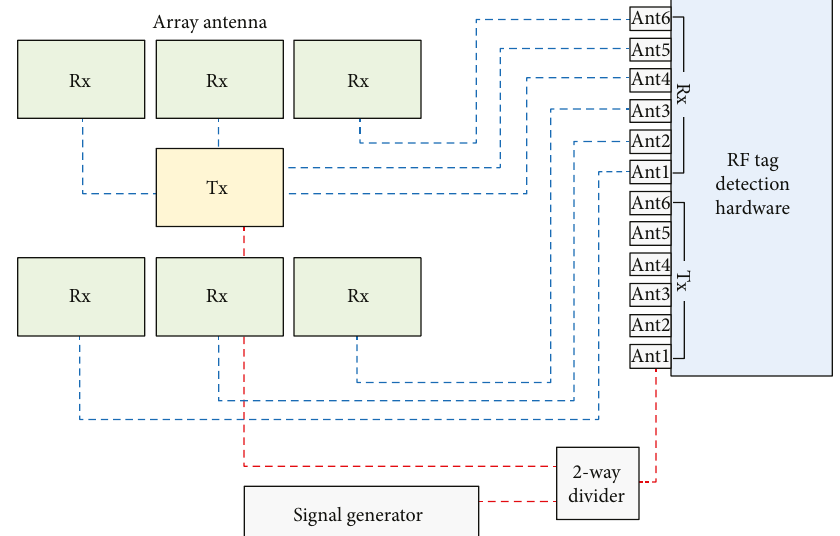
Figure 3: RF security paper detection system block diagram.